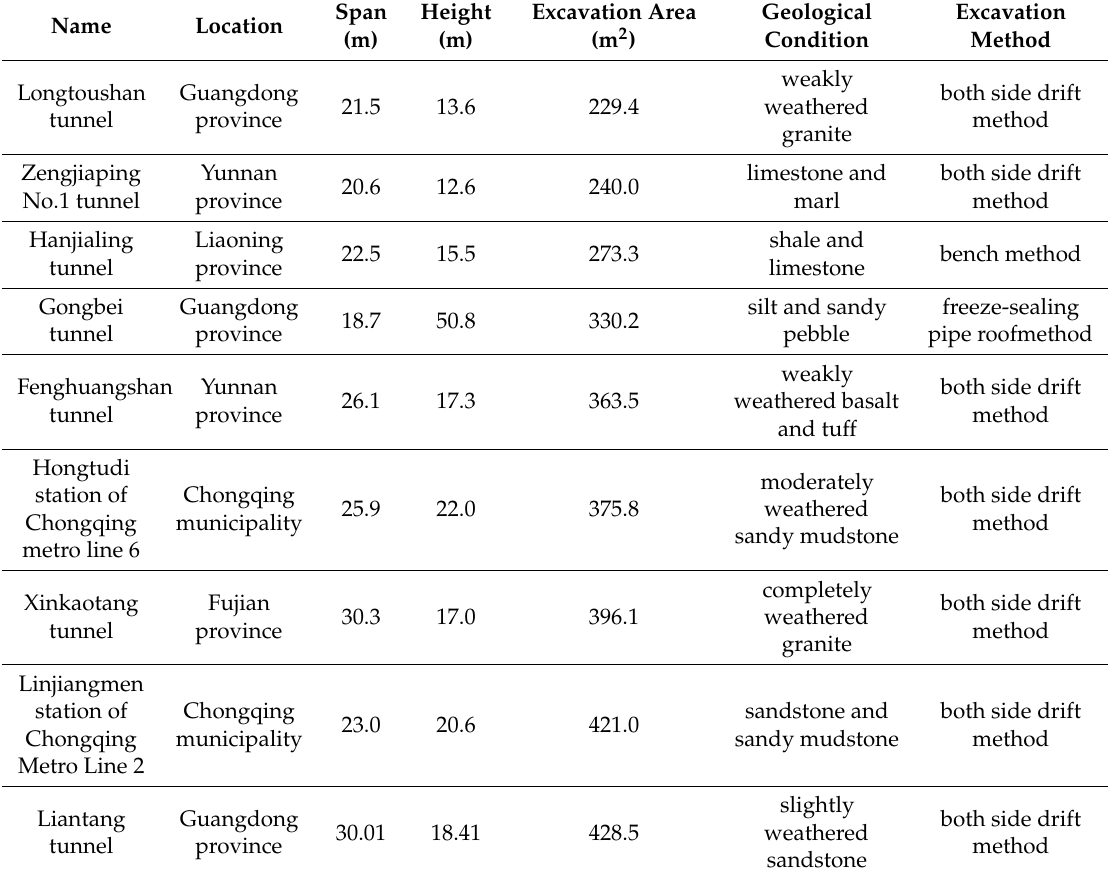
Table 1. Typical examples of super-span tunnels in